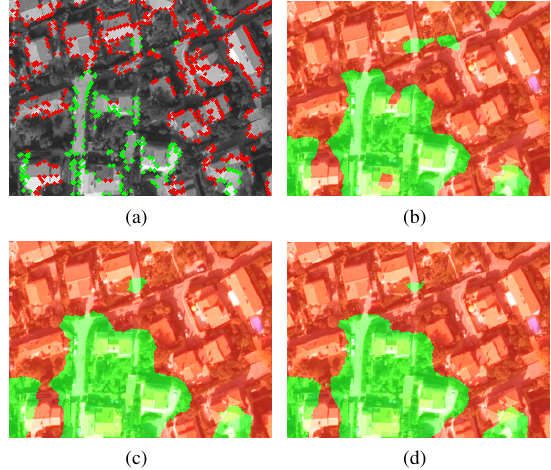
Figure 2: Orientation based classification for q = 2 main orien- tations with k -NN algorithm for image 1(a): (a) shows the classi- fied MHEC point set, (b)–(d) is the classified image with k = 3 , k = 7 and k = 11 parameter values. Different colors show the clusters belonging to the bimodal GMs in figure